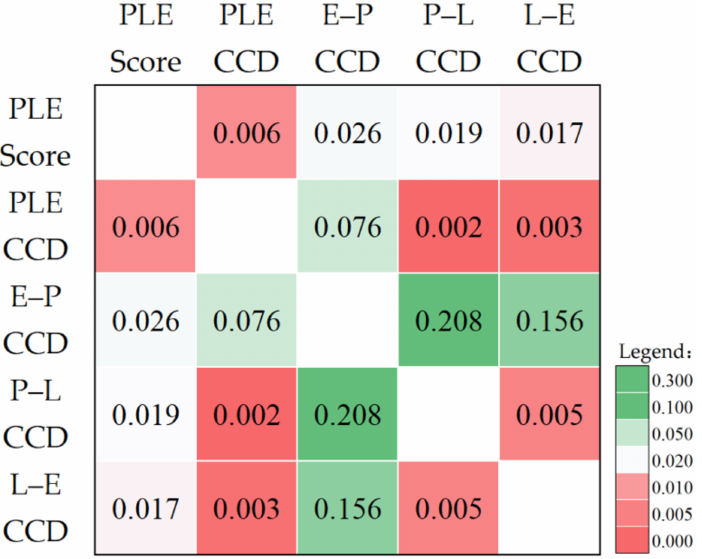
Figure 8. The significance of Pearson results between the PLE score, PLE CCD, and pairwise mutual